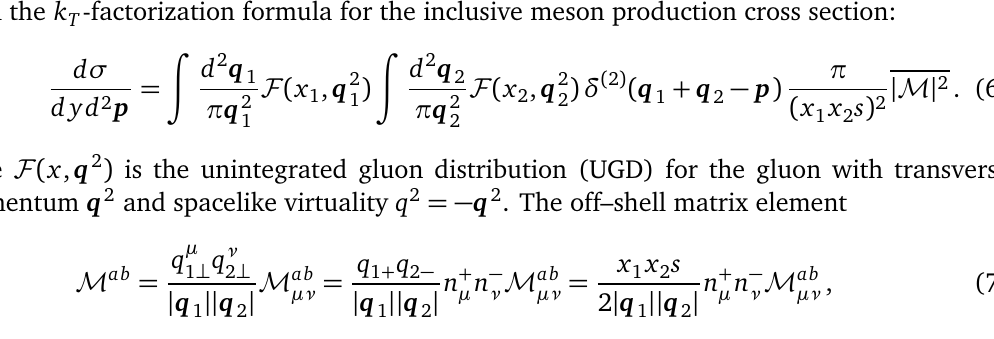
Figure 3: Panel a): Differential cross section for η s = 7TeV. The dashed curve shows the result obtained neglecting the off-shellness of gluons in the hard matrix element. From Ref. [ 6 ] . Panel b): results for χ duction. We show the helicity decomposition of the cross section encoded in two independent form factors. Figure taken from Ref. [ 7 ]